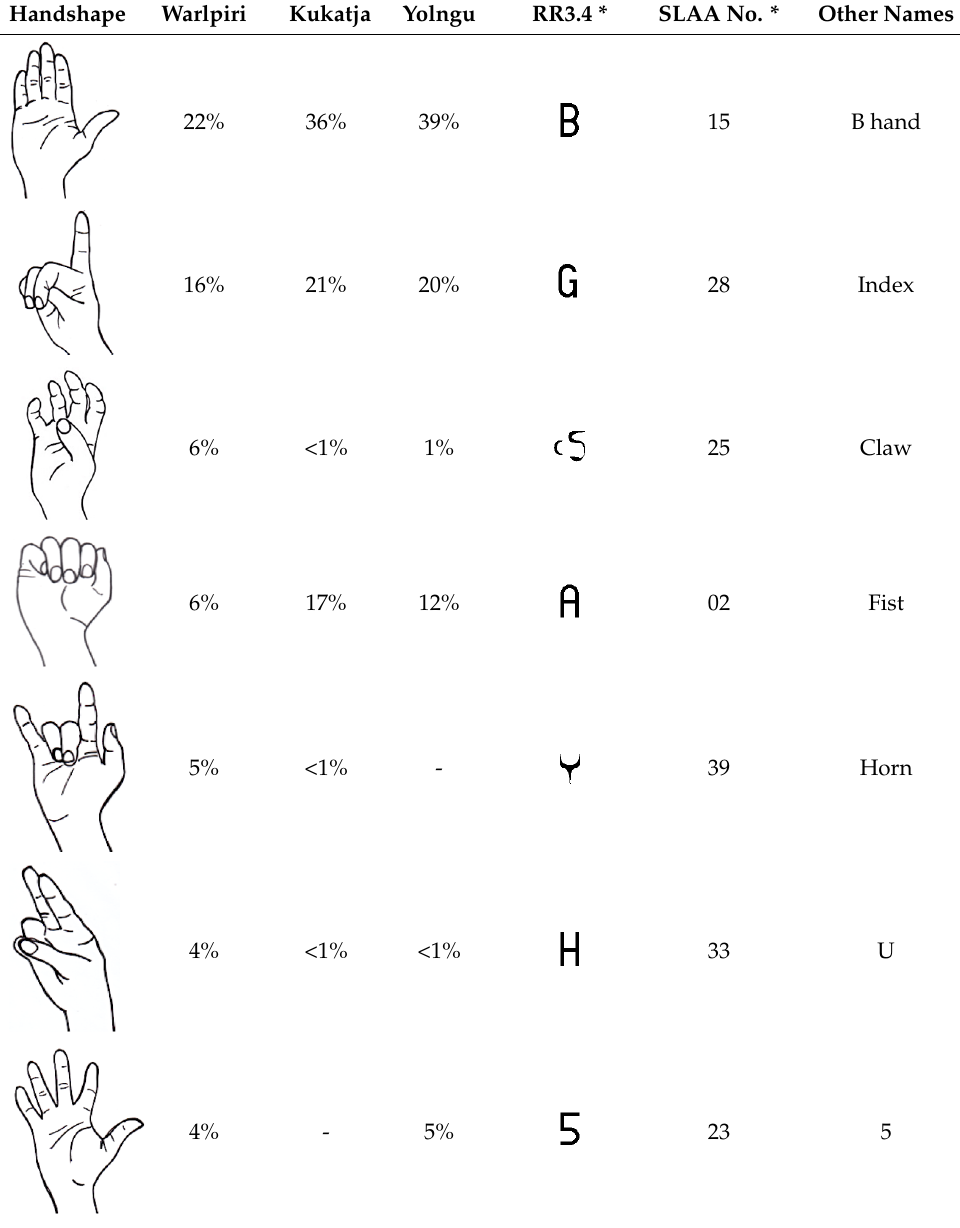
Table A1. Frequency of contrastive handshapes in Warlpiri, Kukatja and Yolngu.